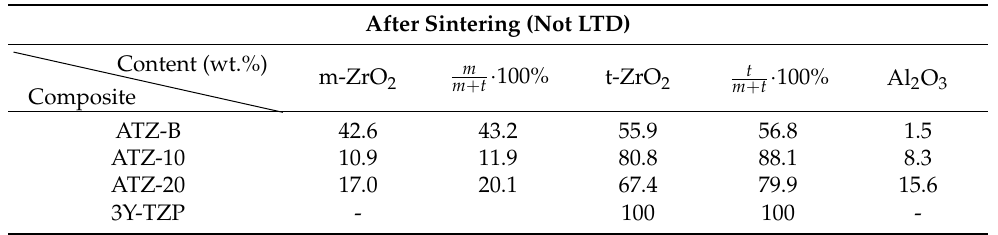
Table 4. Phase content of the ATZ composites and 3Y-TZP reference material in the initial state (after sintering) estimated by Rietveld refinement. m/(m + t) and t/(m + t) are the m-phase content and t-phase conten in relation to the total amount of ZrO 2 phase, respectively. After Sintering (Not LTD) CompositeContent